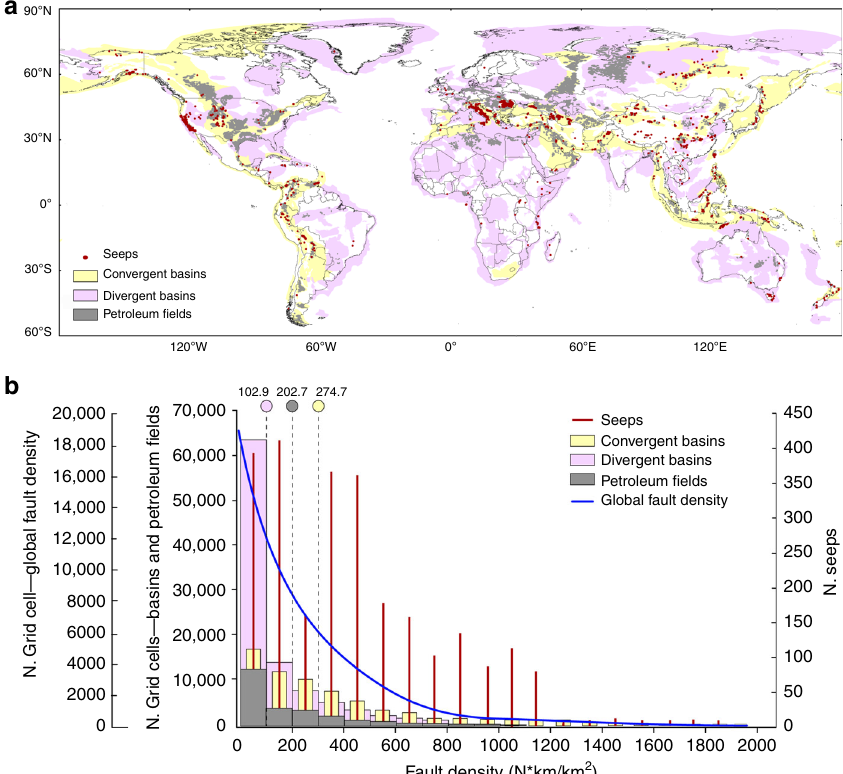
Fig. 2 World map of sedimentary basins, petroleum fi elds and seeps, and related fault density. a Map of sedimentary basins (convergent, light yellow; divergent, light violet), petroleum fi eld areas (grey) and geo-CH 4 seeps (red dots). b Multiple histograms of fault density values at global scale (blue line), in convergent (light yellow) and divergent (light violet) basins, in petroleum fi elds (grey), and at seep location (red). Grid cell is 0.2° × 0.2°. The fault density mean value for divergent basins, petroleum fi elds and convergent basins is indicated above the light violet, grey and yellow circles, respectively.